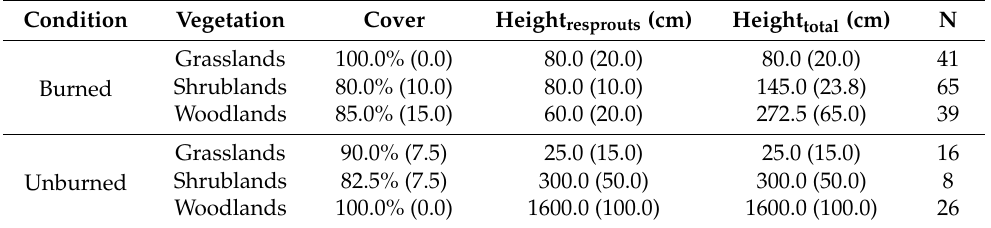
Table 5. Median values of percent coverage, the height of resprouts, and the total height of vegetation. Values in brackets indicate median absolute deviations. N = number of plots.